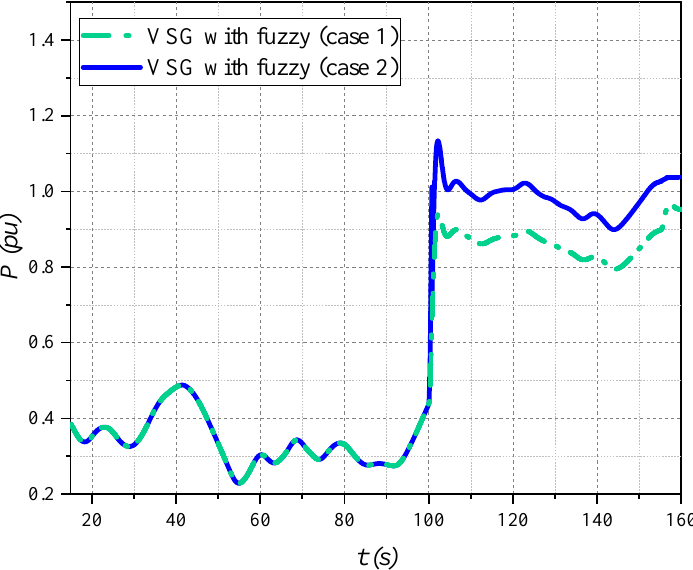
Figure 30. DER 1 output active power for the various scenarios presented in Section